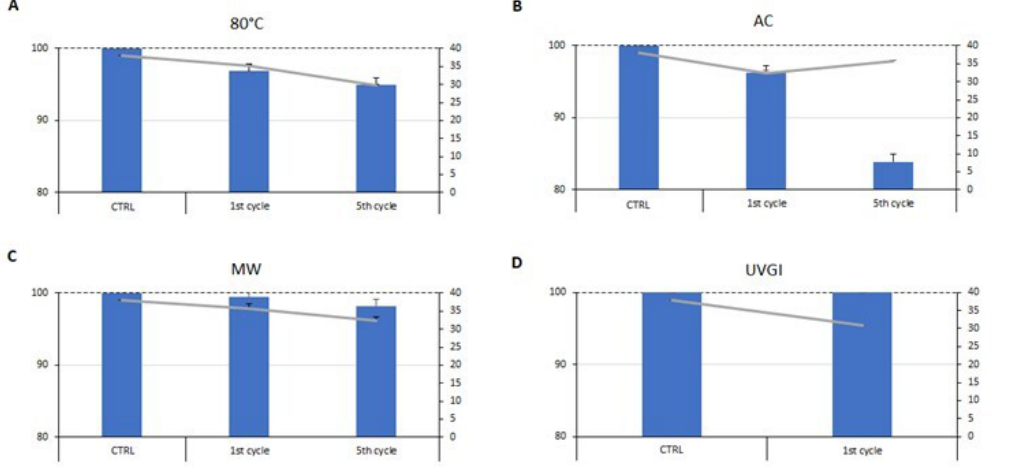
Figure 3. Evaluation of bacterial filtration efficiency (BFE, %) and breathability (BRE, Pa/cm 2 ) post decontamination methods on a soiled single-use surgical mask after the first and fifth cycle of each decontamination method. ( A ) immersion in hot water at 80 °C (80 °C); ( B ) autoclave steam (AC); ( C ) microwave-assisted sterilization (MW); ( D ) ultraviolet germicidal irradiation (UVGI). CTRL, clean surgical mask. Results are reported as mean ± SD of two independent experiments.